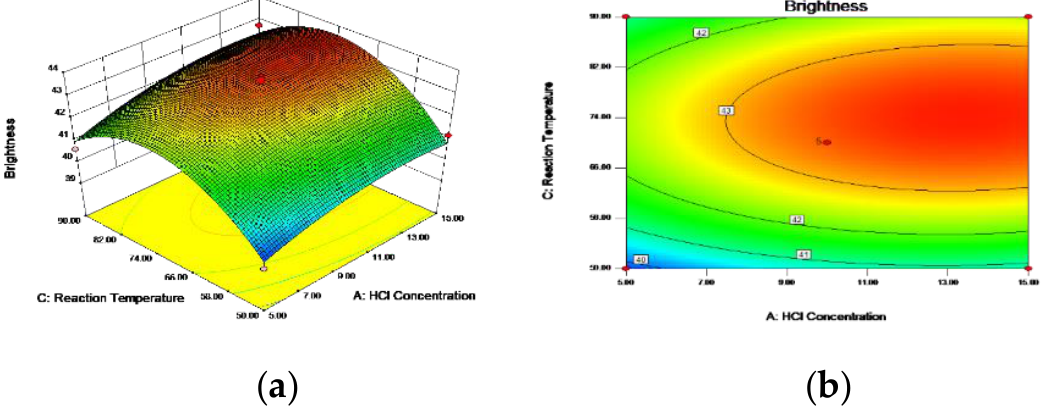
Figure 6. ( a ) The response surface plot and ( b ) the corresponding contour plot showing the effects of HCl Concentration and leaching Time on the brightness of fly ash by removing iron-containing oxides.